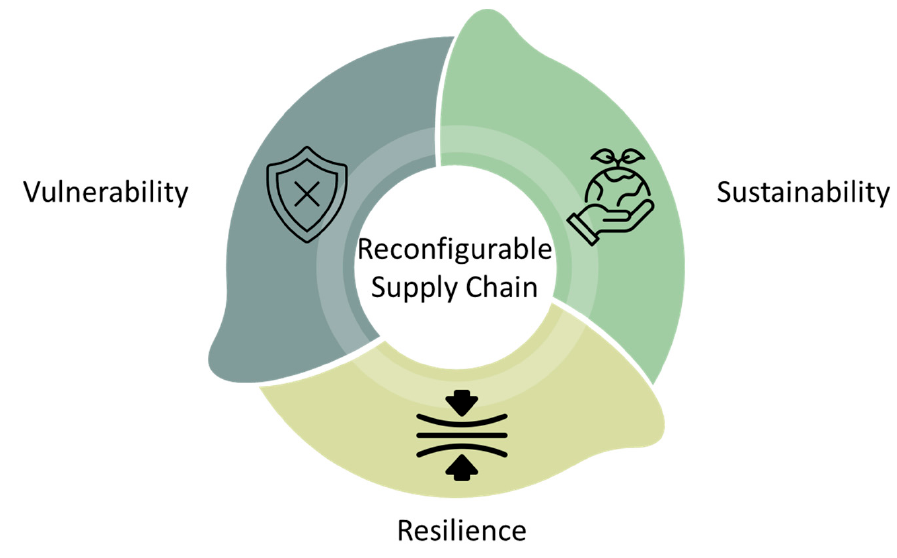
Figure 5. New trends for Supply Chain Configuration in RSC.